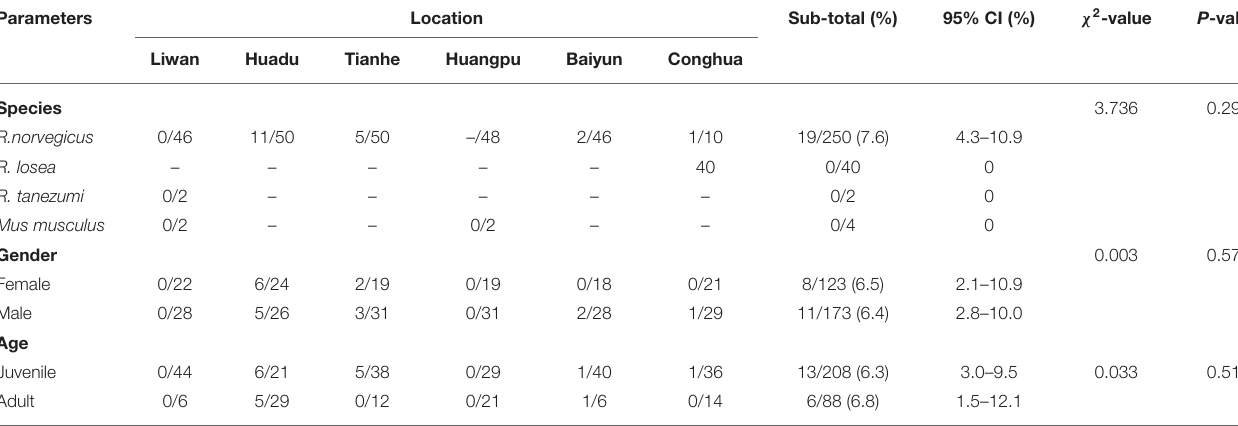
TABLE 2 | Prevalence of Bartonella in rodents collected in urban areas of Guangzhou.